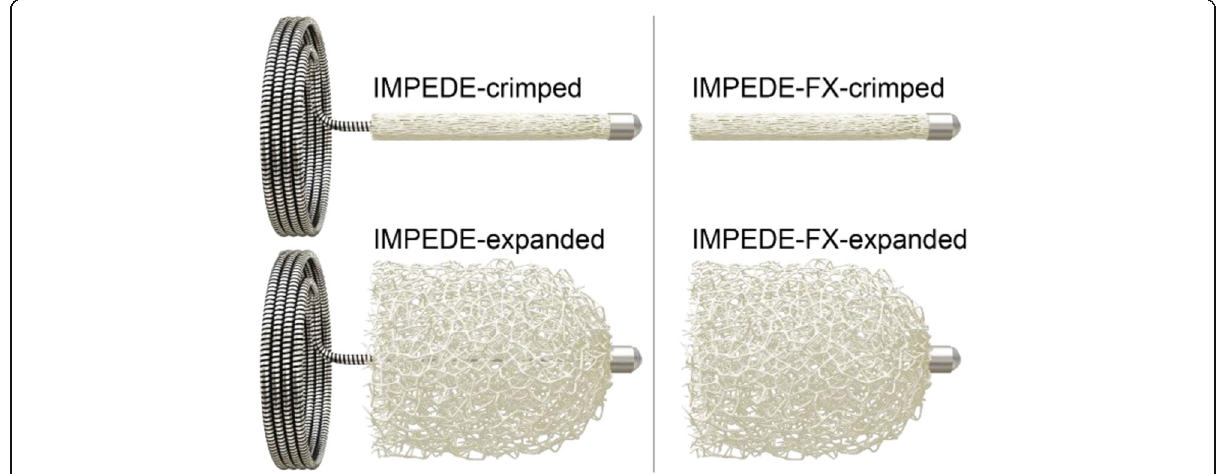
Fig. 1 Illustration of the IMPEDE Embolization Plug (left) and IMPEDE-FX Embolization Plug (right) in their crimped and expanded forms. The difference between the devices is that the IMPEDE-FX device does not have an anchor coil. The devices are available with expanded shape memory polymer diameters of 6 mm, 8 mm, and 12 mm. Illustrations are courtesy of Shape Memory